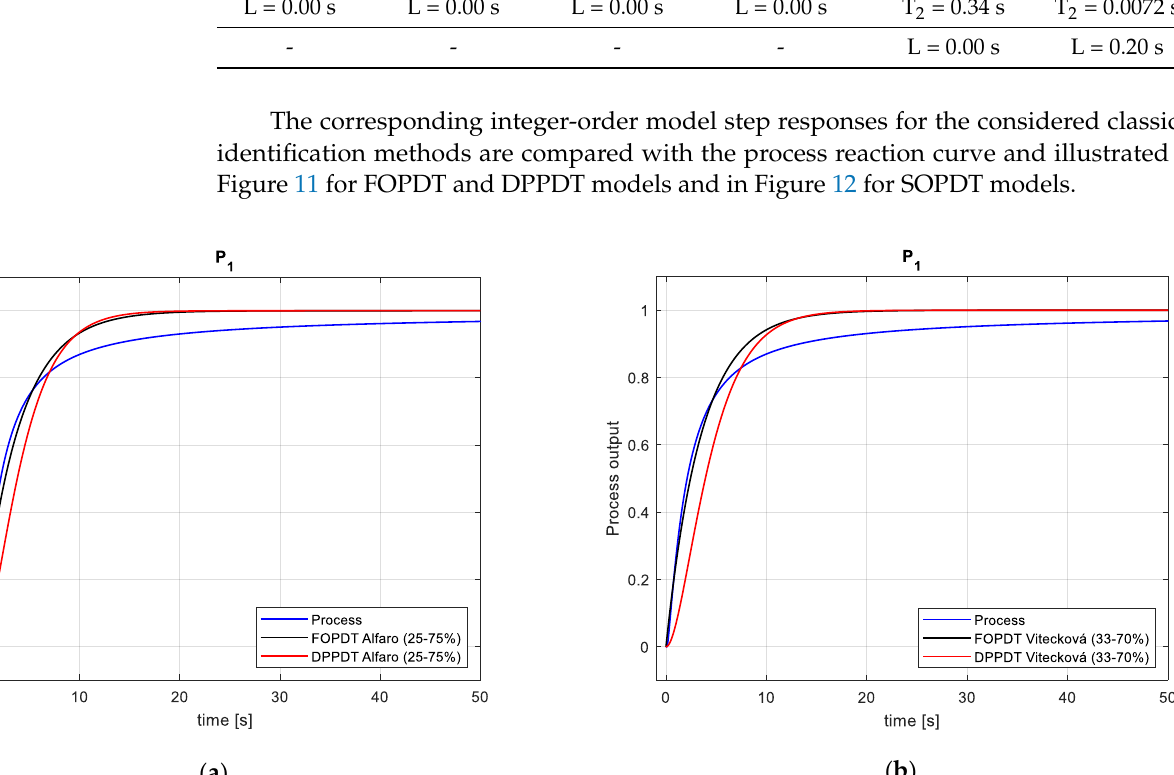
Figure 12. SOPDT model step responses using methods proposed by Stark [16] (15-45-75%) and by Jahanmiri and Fallahi [15] (2-70-90%) and process reaction curve.